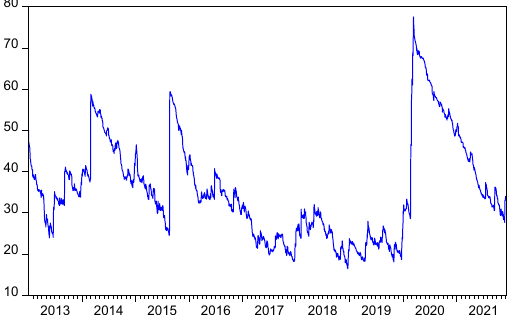
Figure 4. Total volatility spillovers of equity sectors listed on the Polish stock market in the